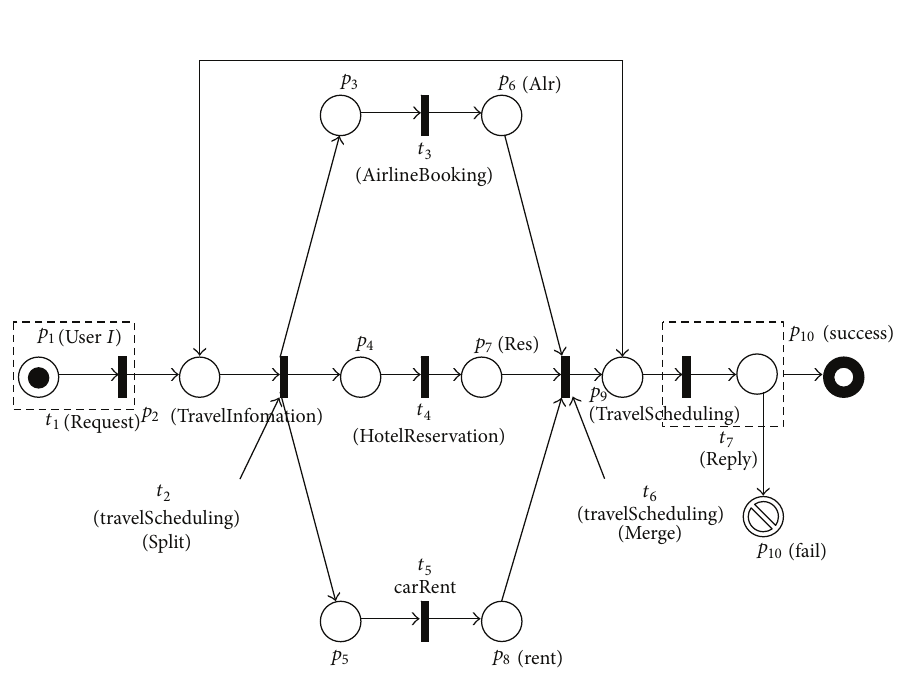
Figure 3: TCWS-CPN for travel scheduling.